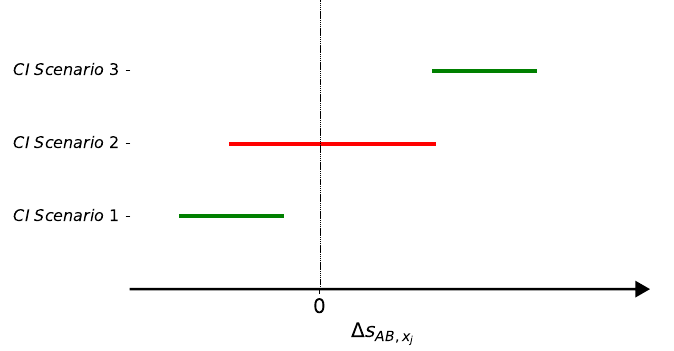
Figure 2. Three possible scenarios for the confidence interval (CI) of ∆ s AB , x selected in Scenarios 1 and